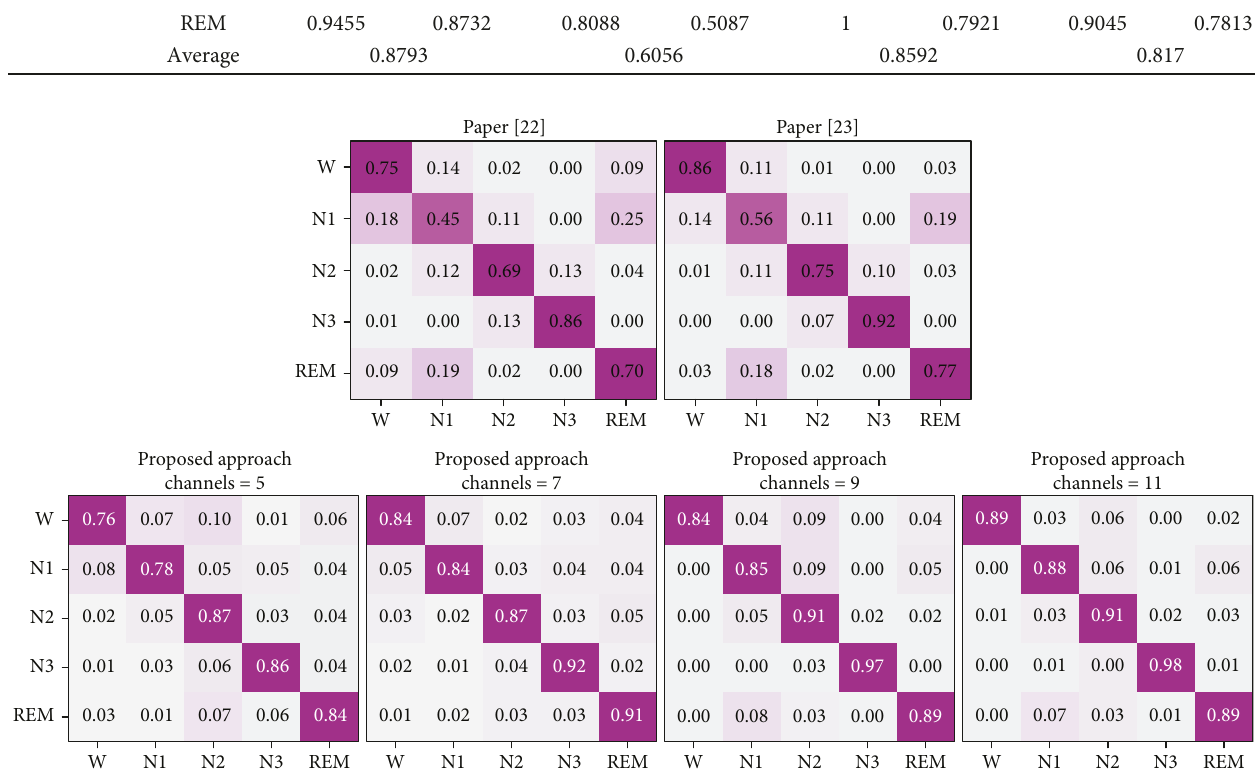
Figure 6: Confusion matrix comparison between the other two methods and the original CNN under four kinds of channel